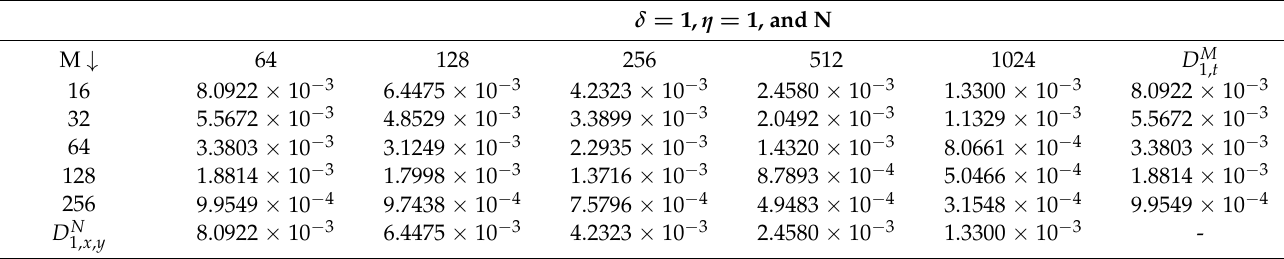
Figure 3. The surface plot illustrates the numerical solution, U 1 , for Case 2 in Example 1. Table 1. U 1 — the component maximum error for Example 1 in Case